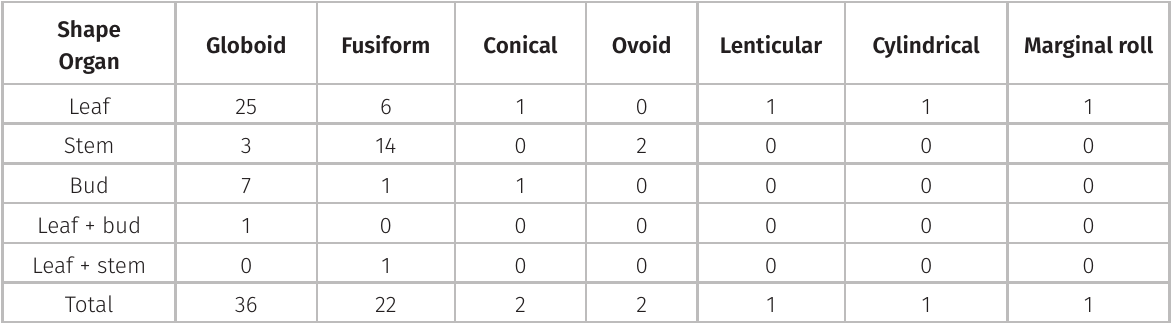
Table III. Richness of insect galls per host plant organ and shape in the Natural Heritage Private Reserve of Serra Negra do Funil (Minas Gerais,